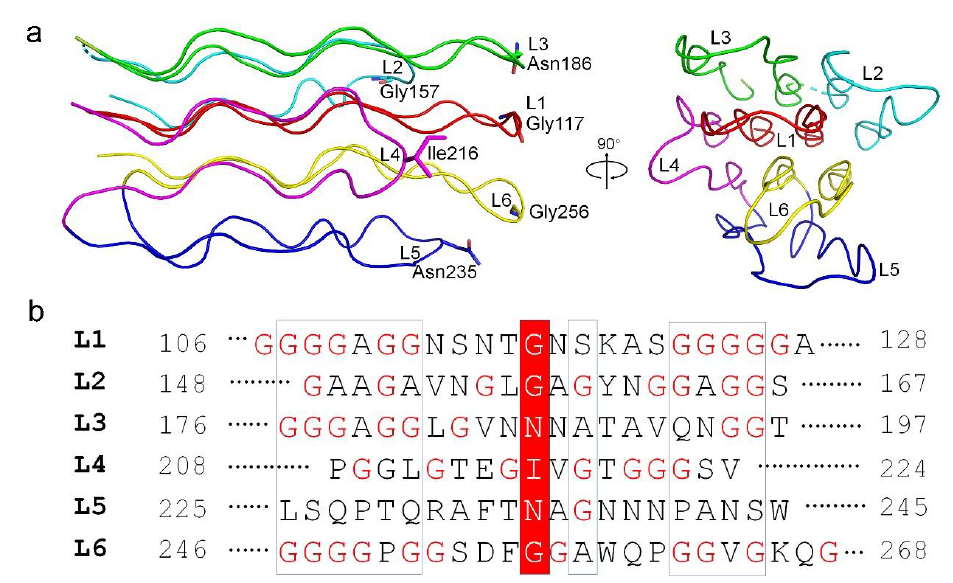
Figure 3. The organization of the glycine-rich domain of gp24. ( a ) The structural arrangement of the six loops, shown in side and top views. Each loop is colored differently. The residues at the outermost of each loop are shown in sticks and labeled. ( b ) Sequence alignment of the six loops (L1~L6) in the glycine-rich domain of gp24. The residues at the distal end of each loop are highlighted in a red box and the glycine residues are marked in red. The numbering of each loop is labeled.